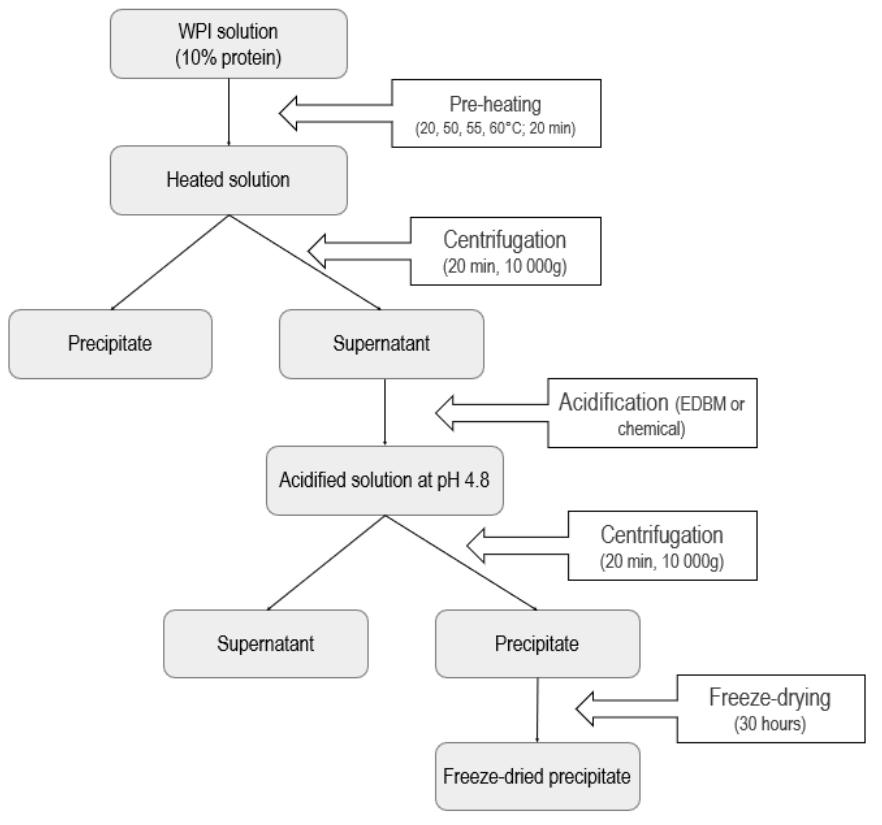
Figure 5. Main stages of the experimental protocol.